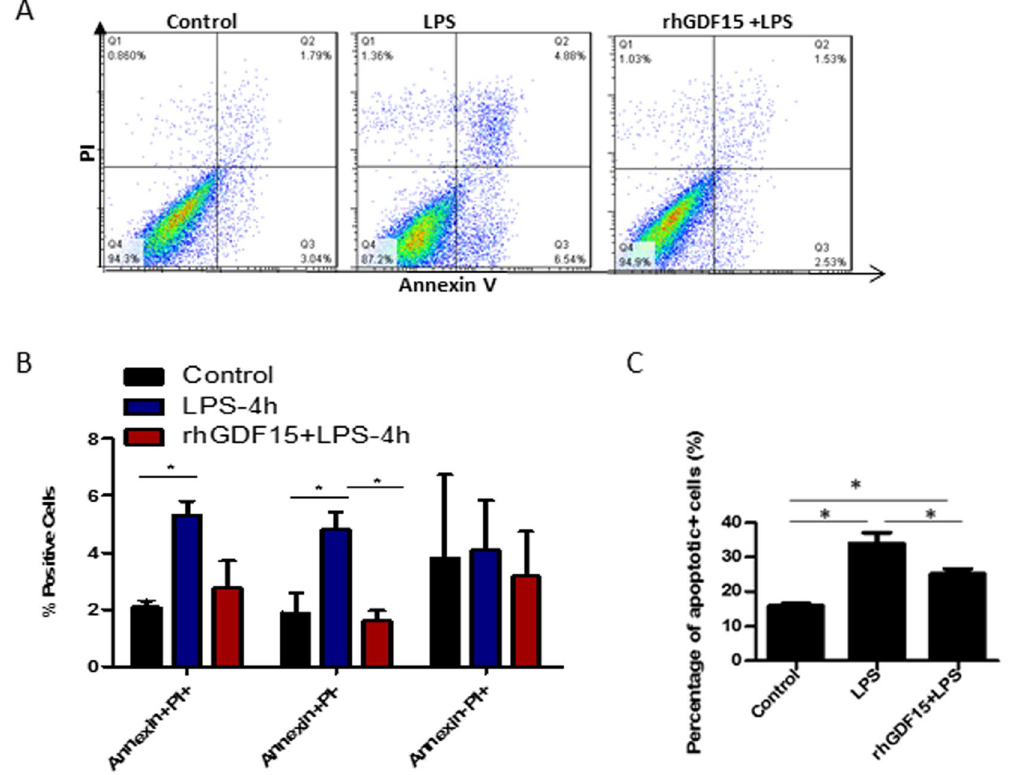
Figure 6. Prior treatment with rhGDF15 reduces the amount of early apoptotic cells seen 4 hours after LPS treatment. Primary kidney tubular cells and primary cardiomyocytes from WT mice were cultured and treated with 25 µ g/ml LPS alone for 4 hs, rhGDF15 two hours prior to LPS treatment or were untreated. Cells were then collected, stained with Annexin V and PI and detected using flow cytometry. Representative dot plots are shown for each treatment group ( A ). Summarized data for kidney cells are shown in ( B ) and for heart cells in ( C ). Data are representative of 3 independent experiments; * P ≤